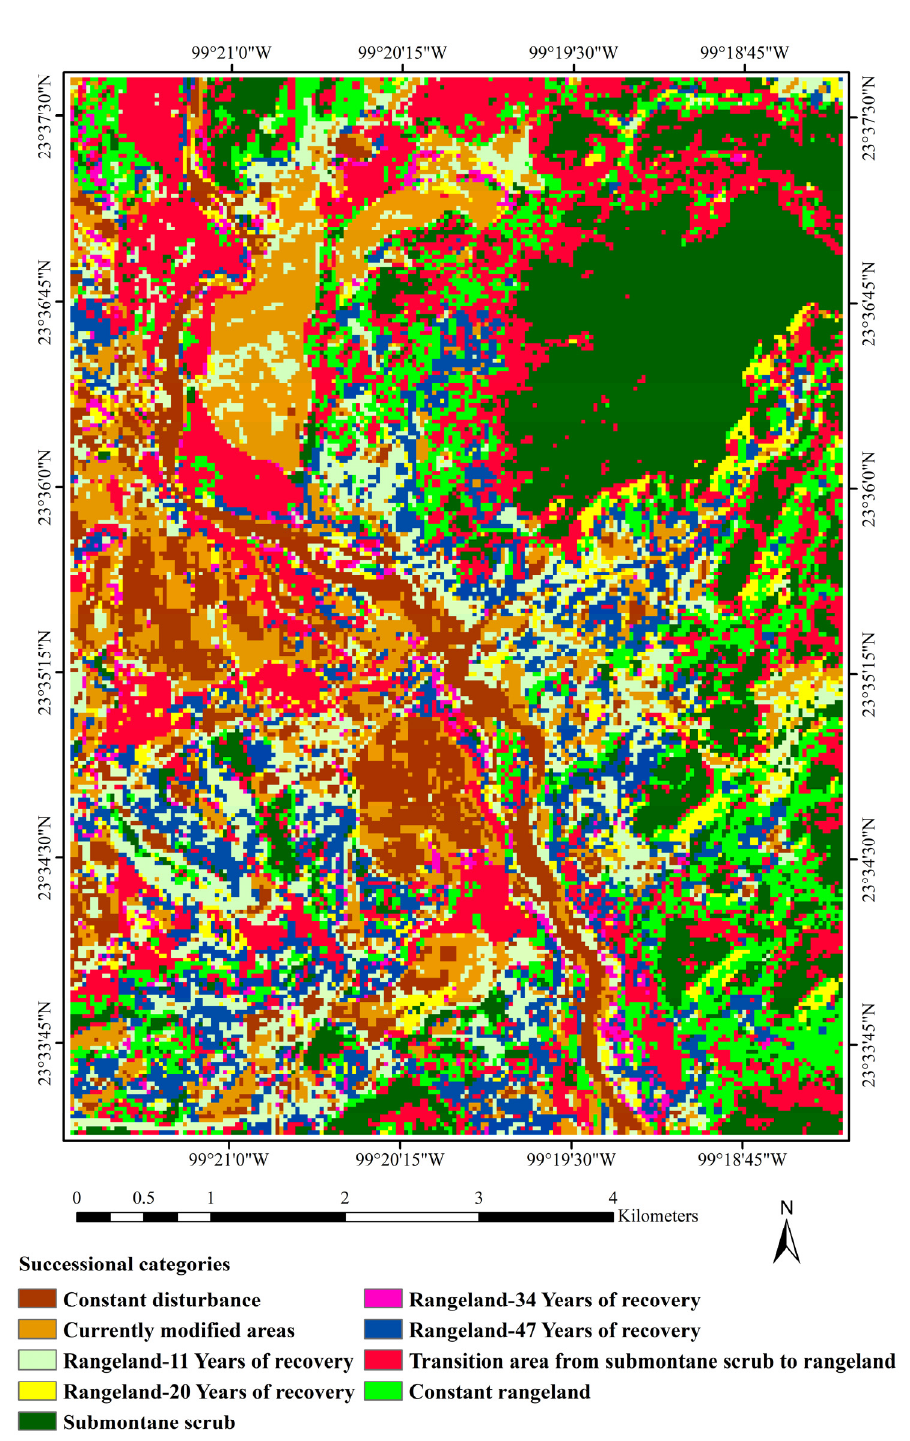
Figure 10. Successive categories of coverage and changes in land use, San Antonio, Jaumave, Tamaulipas, Mexico.